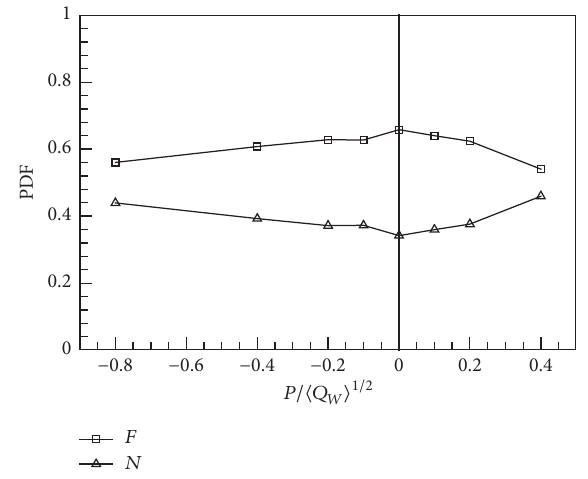
Figure 9: Probability evolution of rotation and strain in the flame zone ( 𝑡 = 501 𝜇 s).